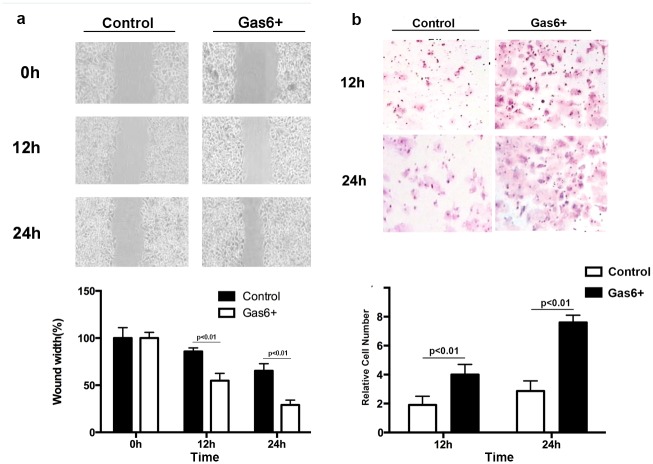
The influence of hrGas6 stimulation on metastatic capacity of YD38 cell.YD38 cell migration by scratch wound healing assay (a); YD38 cell invasion by cell transwell assay (b).